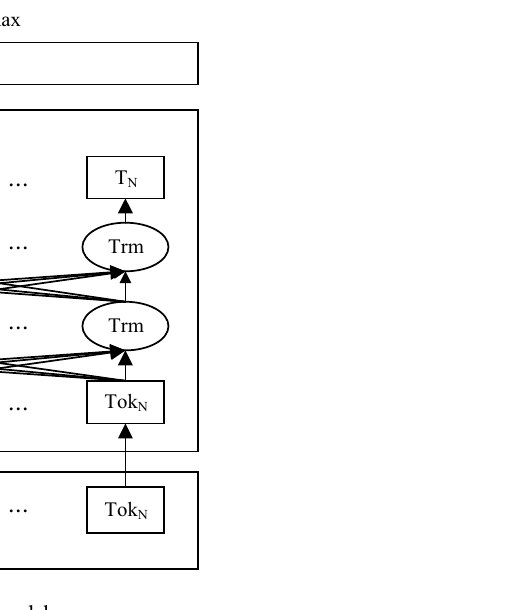
Figure 3. BERT-based text classification